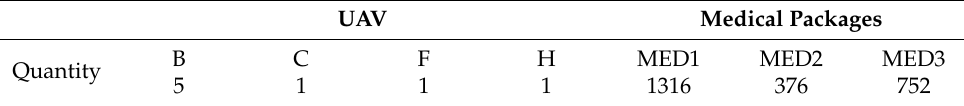
Table 7. ISO container assembly results.